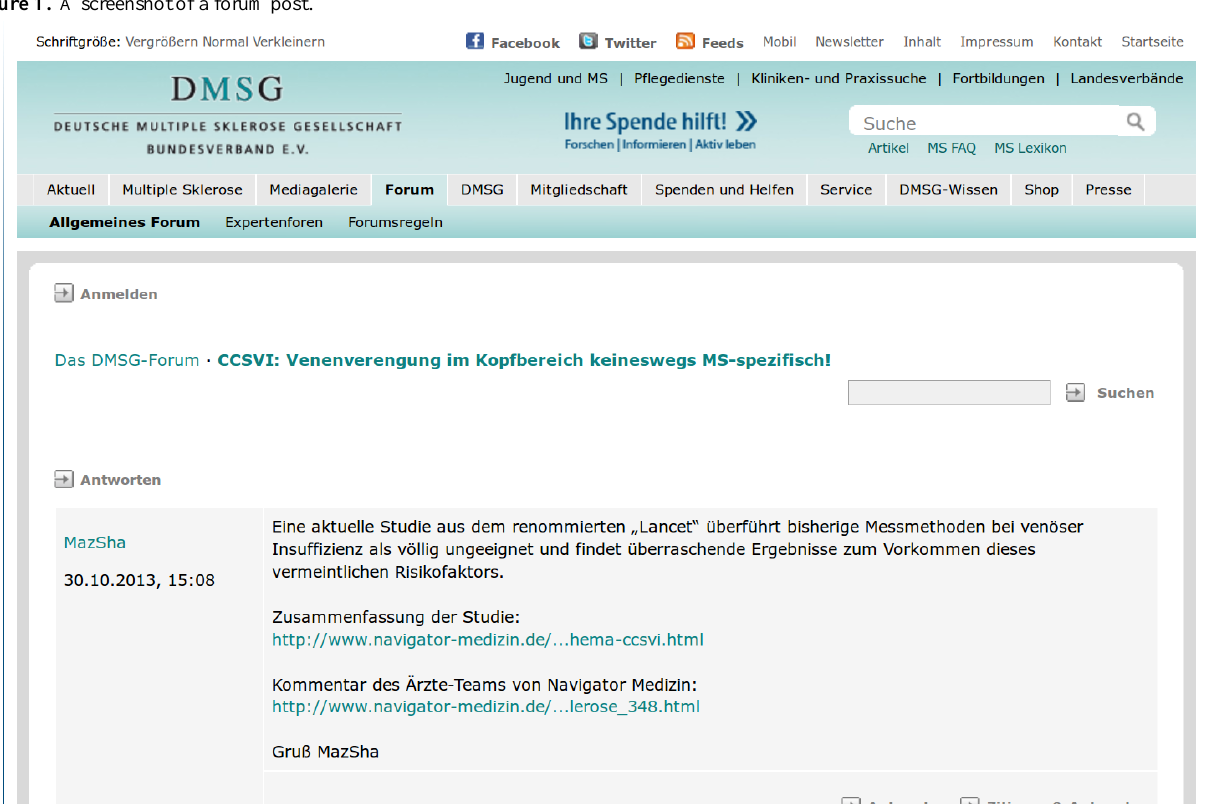
Figure 1. A screenshot of a forum